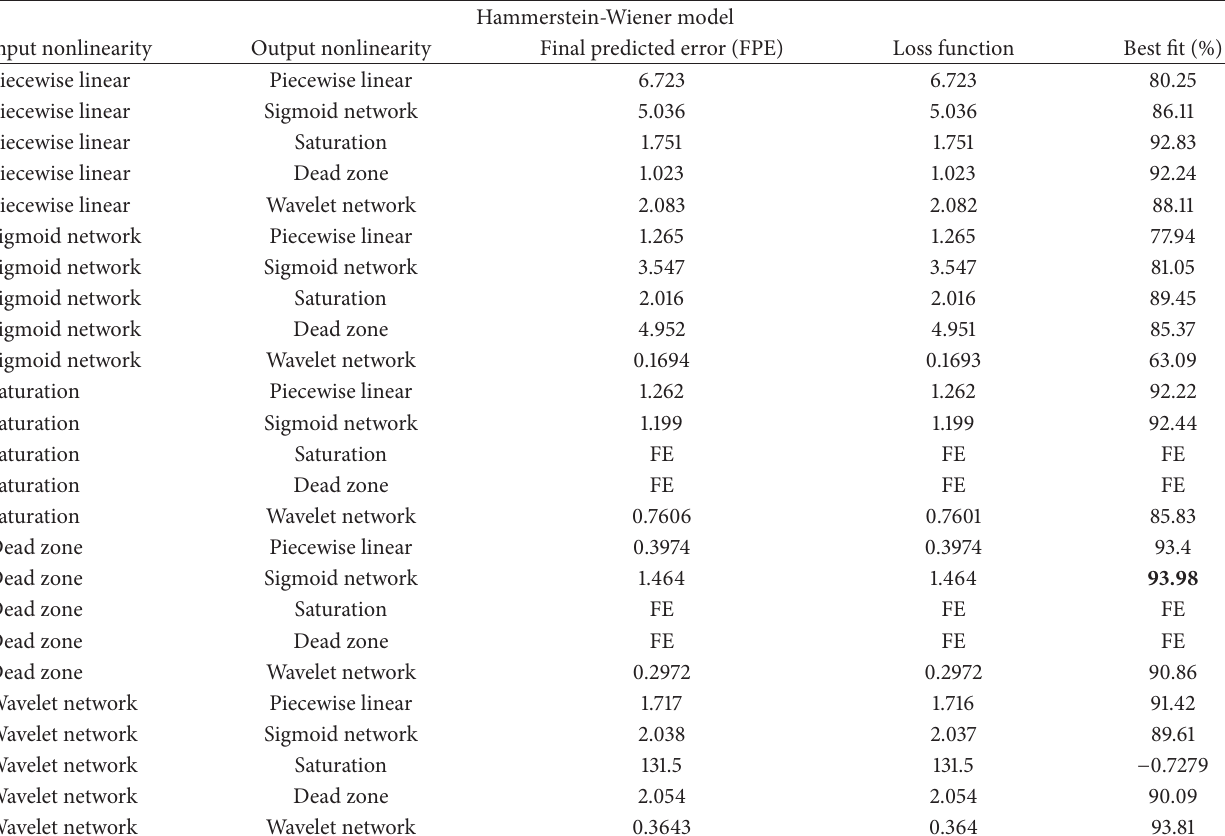
Table 2: Best fit with different input and output nonlinearity. Hammerstein-Wiener